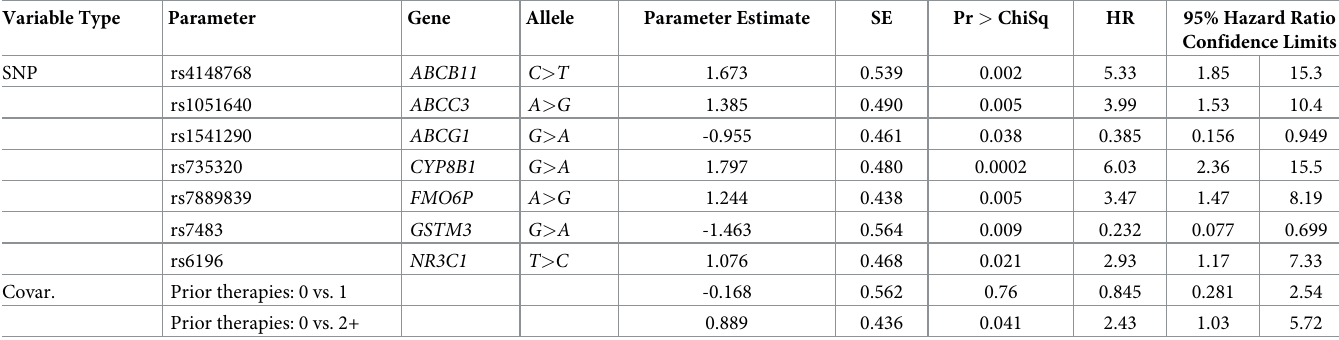
Table 2. Proportional hazards analysis of PFS (N =